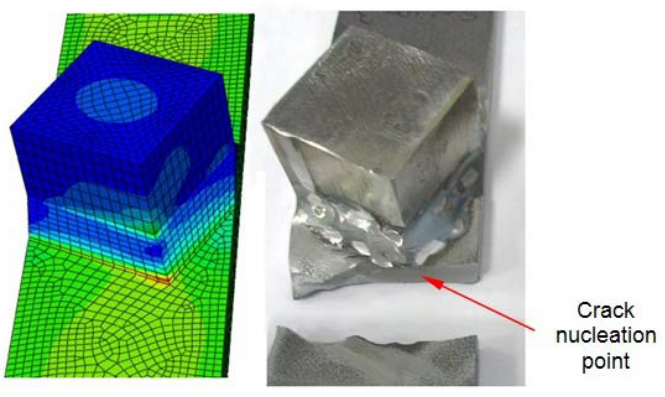
Figure 9: Finite element model using 3D elements and real specimen with the solid block.